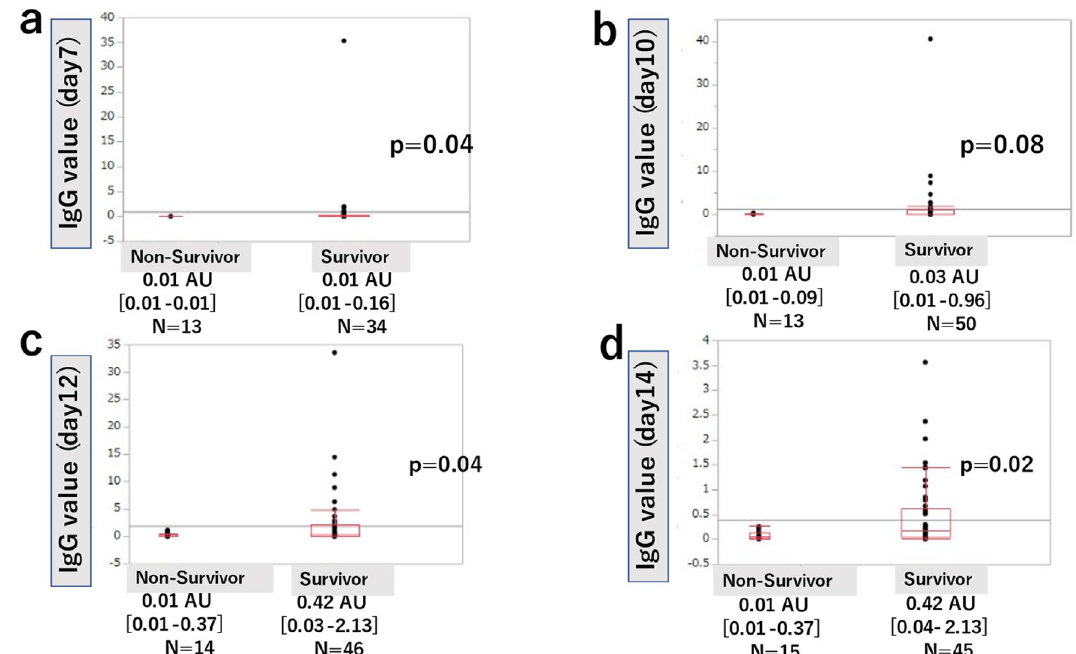
Figure 3. Comparison of daily IgG values between survivors and non-survivors. Antibody titers of IgG on day 10 after onset were not significantly different between the survivor and non-survivor groups ( b ). Antibody titers of IgG on day 7, 12, and 14 after onset were significantly higher in the survivor group ( a , c , d ). Values represent median and interquartile range. N total number of patients. P < 0.05 indicates a significant difference. IgG immunoglobulin G.